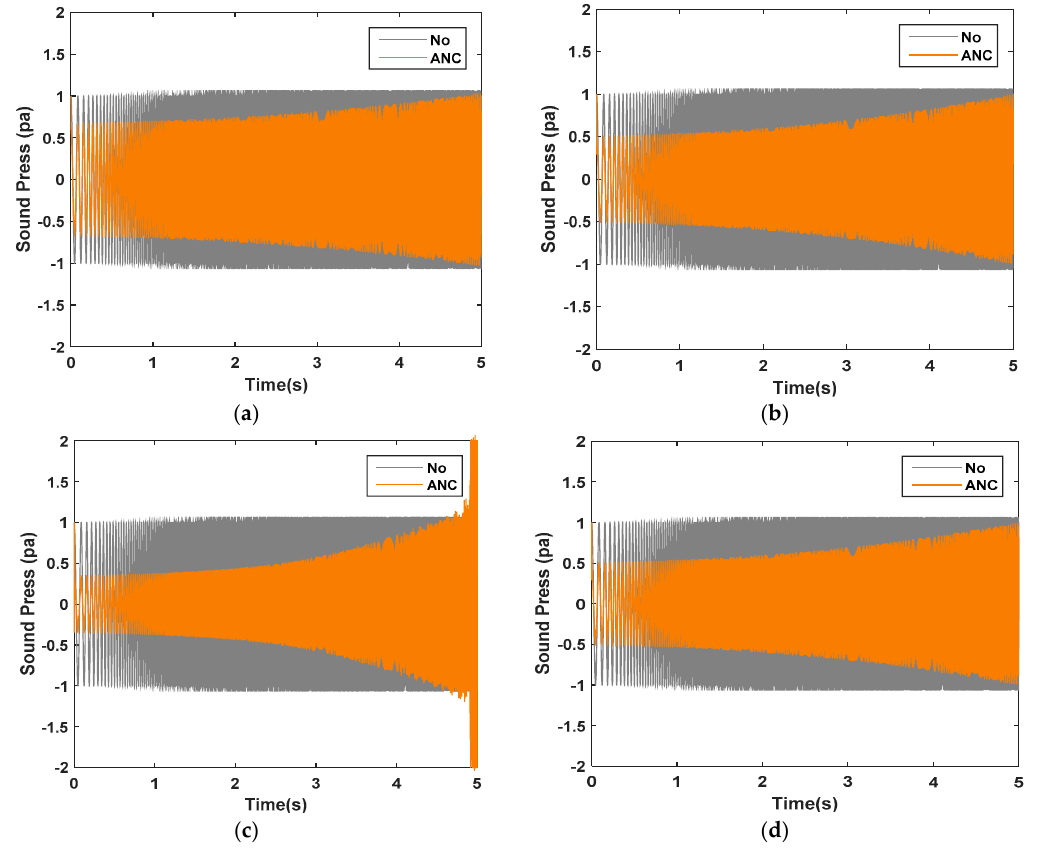
Figure 3. Time history and PSD of signal 1 controlled by the normalized least mean squares filter (NLMS) algorithm-based adaptive notch filter with two weights ( L = 2) and leakage factor ( γ = 0.5). ( a ) Time history ( µ = 0.5); ( b ) Time history ( µ = 2); and ( c ) Time history ( µ = 3); and ( d ) Figure 4a–c illustrates the time history of the error signal controlled by the